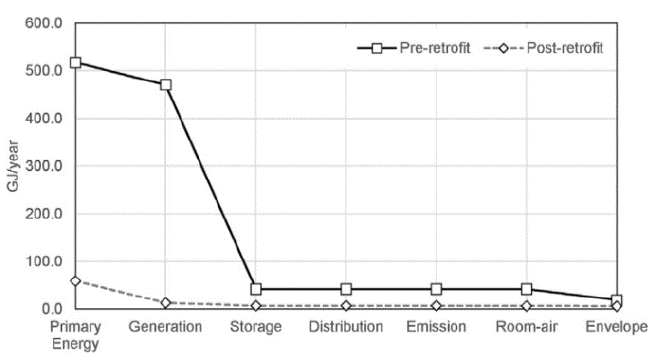
Figure 7. Exergy flows: Comparison before and after retrofit [29].